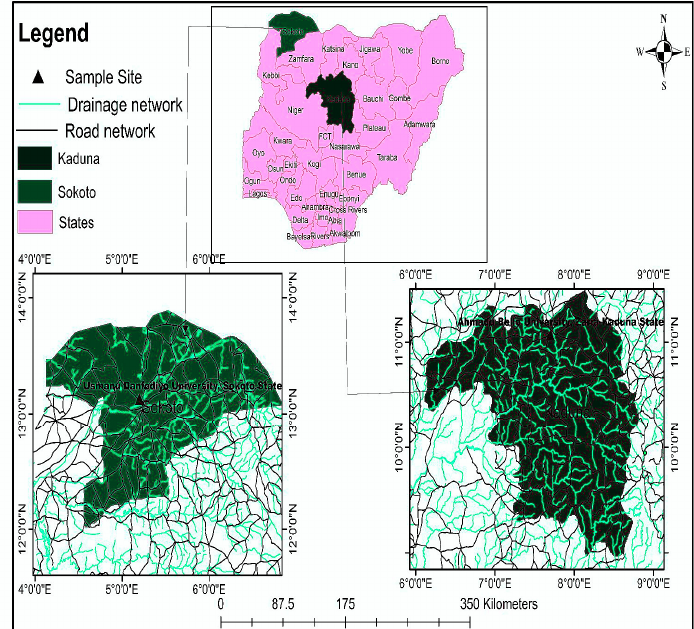
Fig. 1. Map of Nigeria showing the study sites in Kaduna and Sokoto States